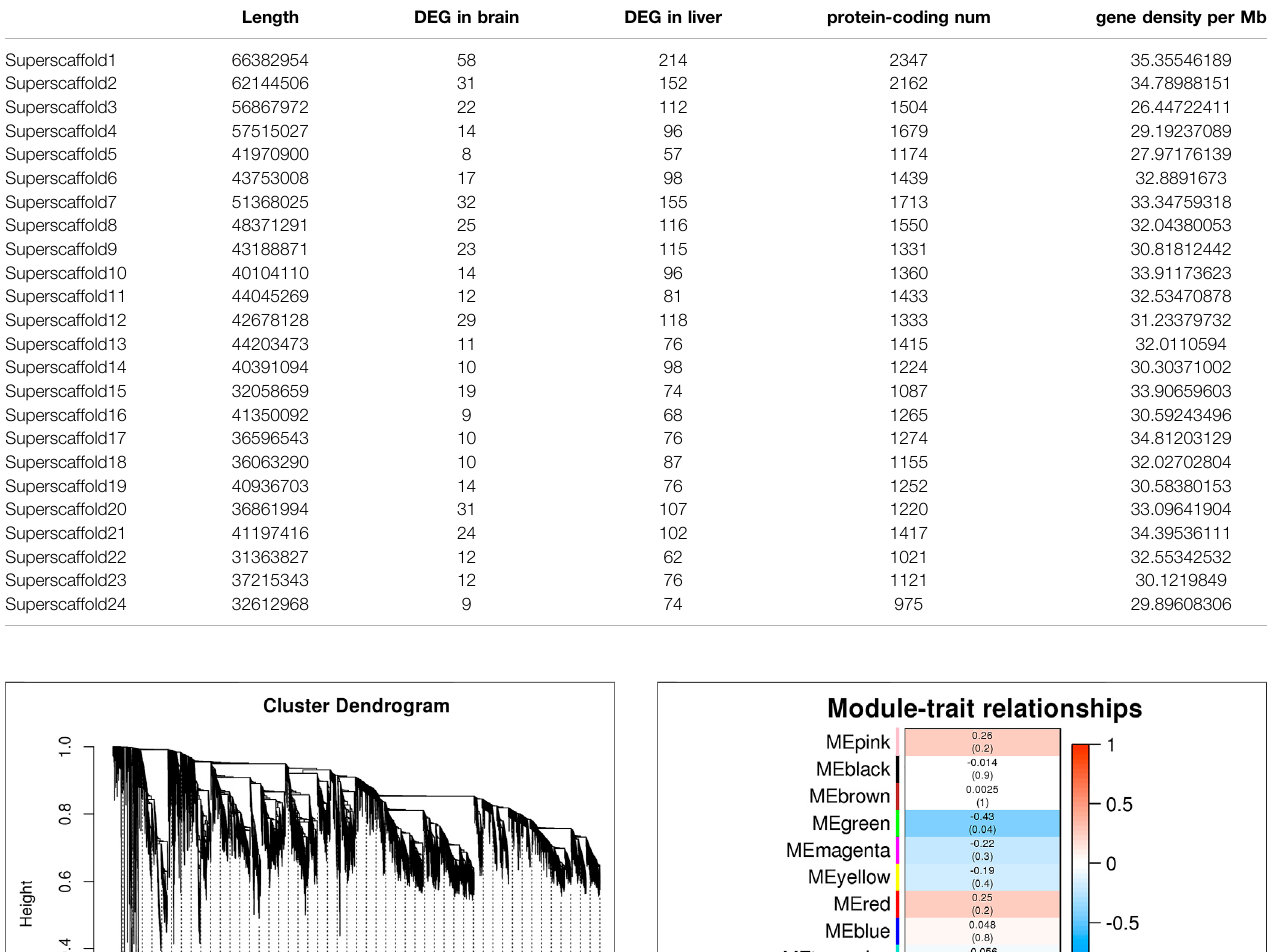
TABLE 2 | The uneven distribution of DEGs on each chromosome in brain and liver